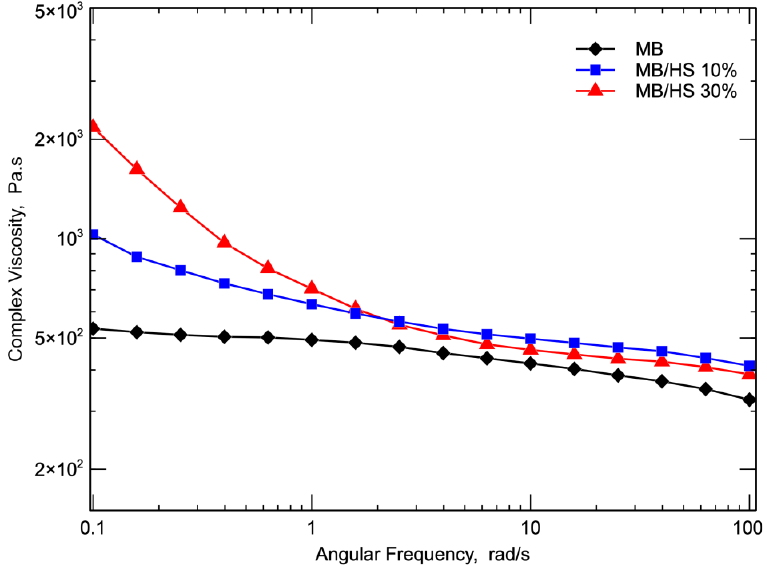
Figure 5. Complex viscosity as a function of frequency of MB and biocomposites.